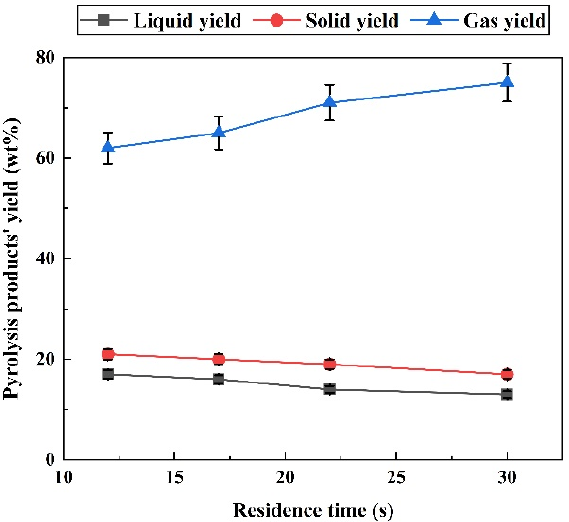
Figure 1. Effect of residence time on the distribution of pyrolysis products of pine sawdust at 850 °C without catalyst.